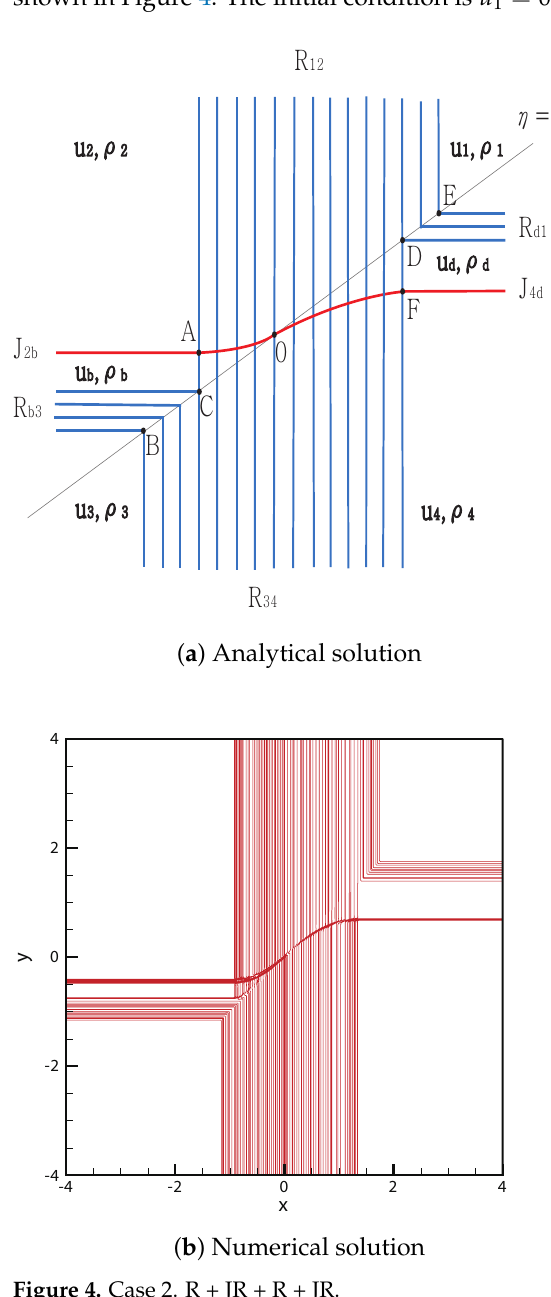
Figure 4. Case 2. R + JR + R +